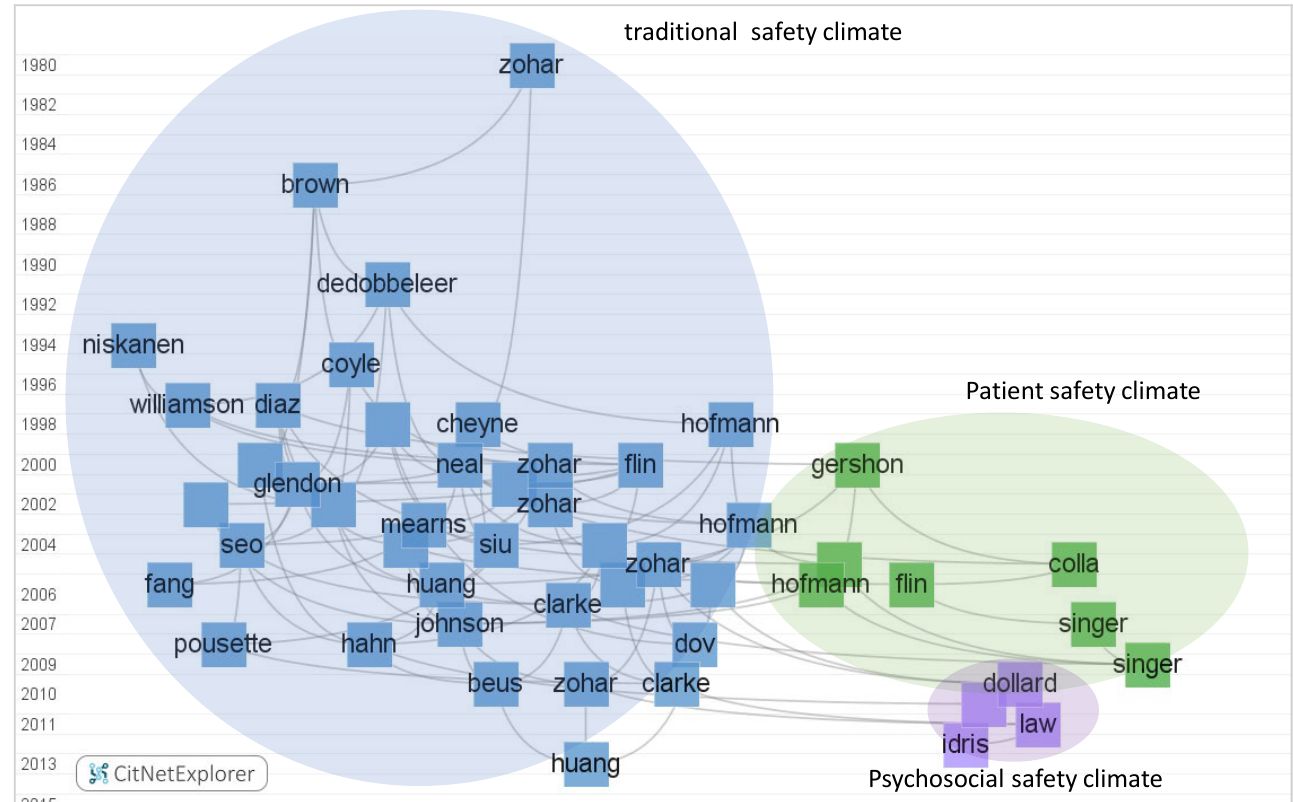
Figure 10. Direct citations network of safety climate publications: the top 50 most cited papers on safety climate are included in the current network. For details, see Supplementary Material Table S1. (Generated by CitNetExplorer; see Section 2.2 for references.)